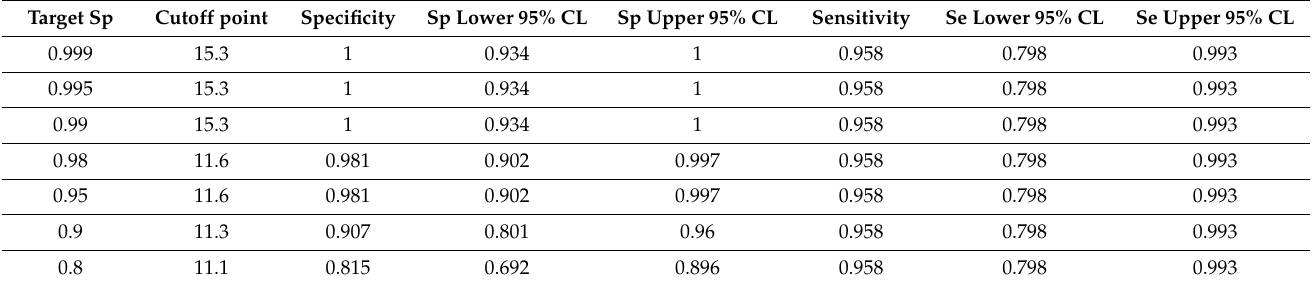
Table 7. Cutoff-point results for target specificity of a-MMP-8 level at T1.